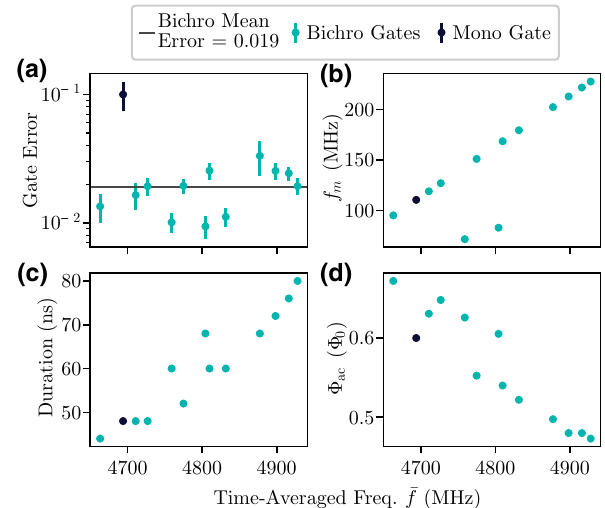
FIG. 9. (a) The gate error for 12 bichromatic CZ 02 gates between qubit 3 and qubit 4, measured via interleaved random- ized benchmarking and plotted against the time-averaged fre- quency of qubit 1 during modulation. The gates include both k = − 2 and k = − 4 sideband interactions, all operated at dynamical sweet spots. The k = − 2 gate at the single monochromatic sweet spot is included for comparison. The monochromatic k = − 4 gate is not brought up due to the required f m being too low for the filtration scheme in use. (b) Modulation frequencies f m for each operating point. The distinct linear sets correspond to the two sidebands being used to activate the gates [see Eq. (3)]. (c) Gate times for the full set of operating points. The native CZ 02 inter- action involves two full | 11 (cid:5) ↔ | 02 (cid:5) swaps, the rate of which is determined by the weight of the activating sideband. (d) Modu- lation amplitudes (cid:2) ac , all of which satisfy the dynamical sweet ¯ spot condition ∂ f /∂(cid:2) ac = 0 for each set of bichromatic mod- ulation parameters. Details about these operating points can be found in Table